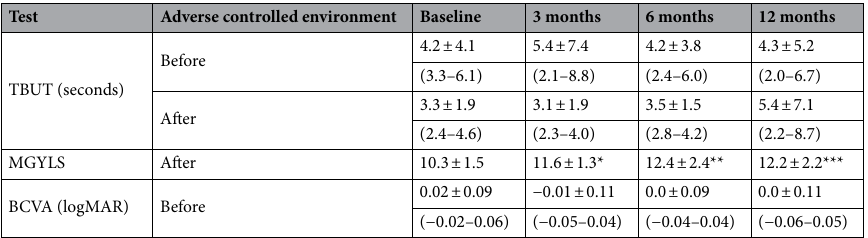
Table 1. Outcomes of Fluorescein TBUT, MGYLS, and BCVA. TBUT = tear break-up time; MGYLS = Meibomian gland yielding liquid secretion; BCVA = best corrected visual acuity; logMar = log minimum angle of resolution. Values are means ± standard deviation and (95% confidence interval). Comparison with baseline value by post-hoc Tukey´s test: * p = 0.008, ** p = 0.0001, *** p = 0.0005.